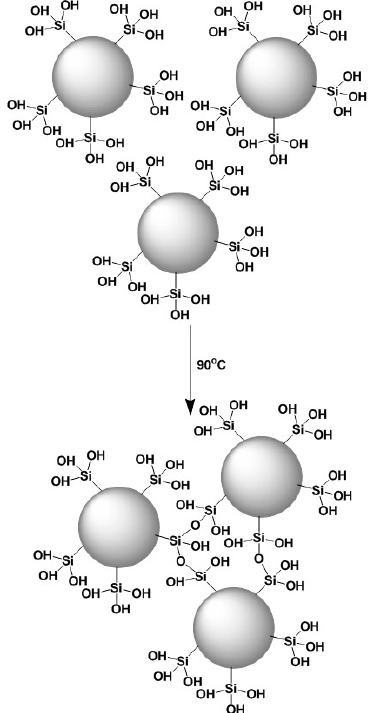
Figure 18. Formation of honeycomb-like PAMAMOS networks from silyl dendrimer precursors (Reproduced with permission from [133,134]; Copyright WILEY-VCH Verlag GmbH & Co., 2006; American Chemical Society, 2002).